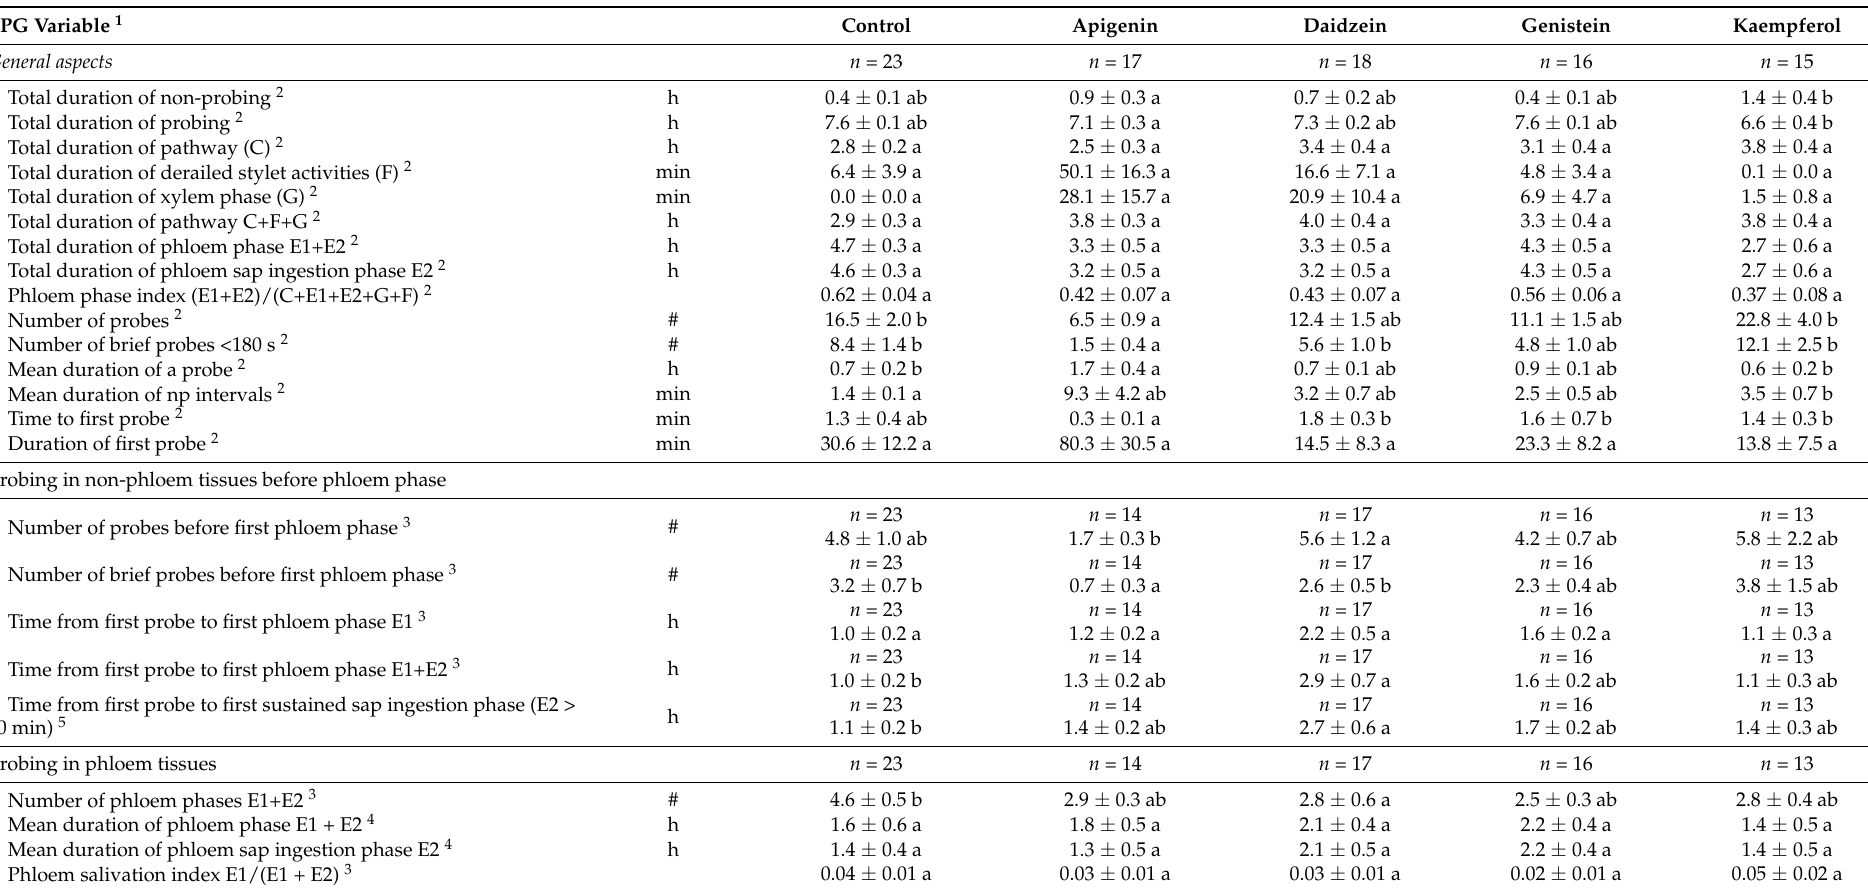
Table 1. EPG-recorded stylet penetration activities of Acyrthosiphon pisum on Pisum sativum treated with 0.1% ethanolic solutions of apigenin, daidzein, genistein and kaempferol. All values represent means ± SD of cumulative time or number of events within an 8 h period. Different letters in rows denote statistically significant differences among treatments (Kruskal–Wallis test, p <